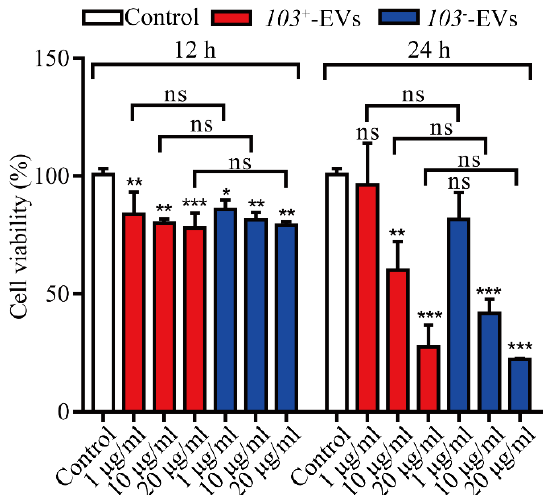
Figure 3. 103 + -EVs and 103 − -EVs induce cytotoxicity in J774A.1 cells. J774A.1 cells stimulated with various concentrations of 103 + -EVs and 103 − -EVs for 12 h or 24 h, then the cell viability measured by cell counting kit-8. The data were compared with the PBS stimulated control cells. The comparisons between groups were performed by one-way ANOVA followed by Tukey’s test. * p < 0.05, ** p < 0.01, *** p < 0.001, and ns, not significant.